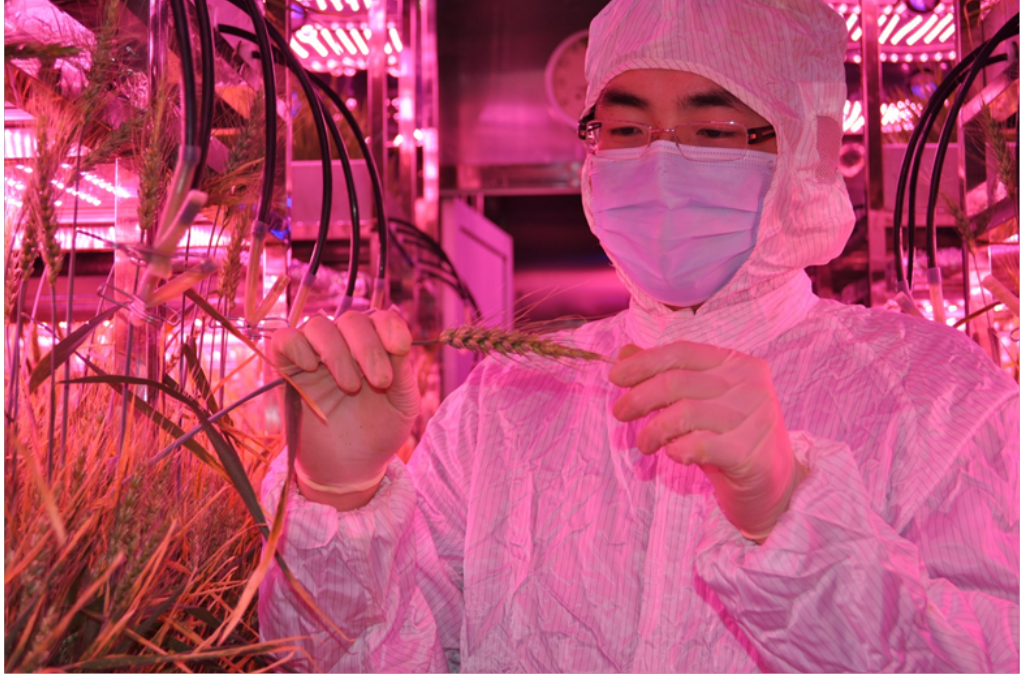
Figure 9. Dr. Chen Dong of Beihang University inspecting wheat plants inside the Lunar Palace 1 facility in Beijing, China. Note the pinkish colored light from high output red and white LEDs to grow the crops that supported three crew members for 105 days. Photo courtesy of Prof. Hong Liu, Beihang